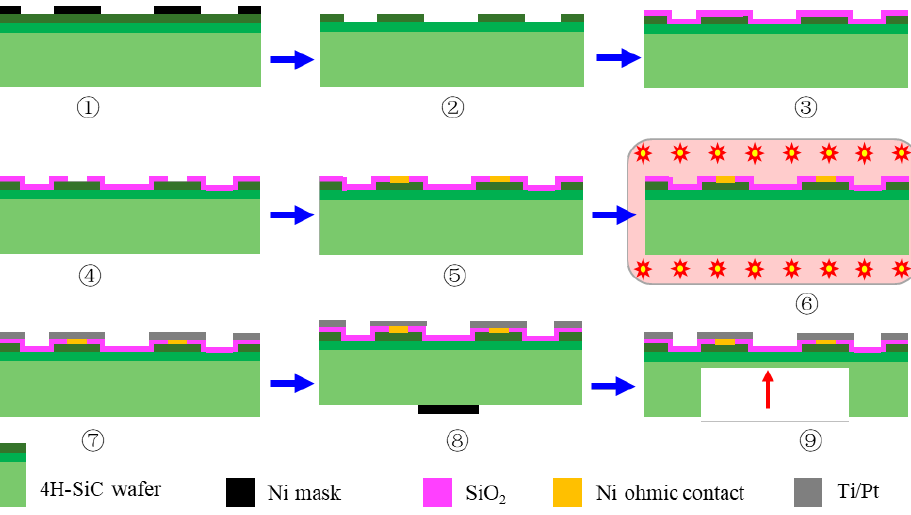
Figure 5. Schematic diagram of the SiC pressure sensor manufacturing process.